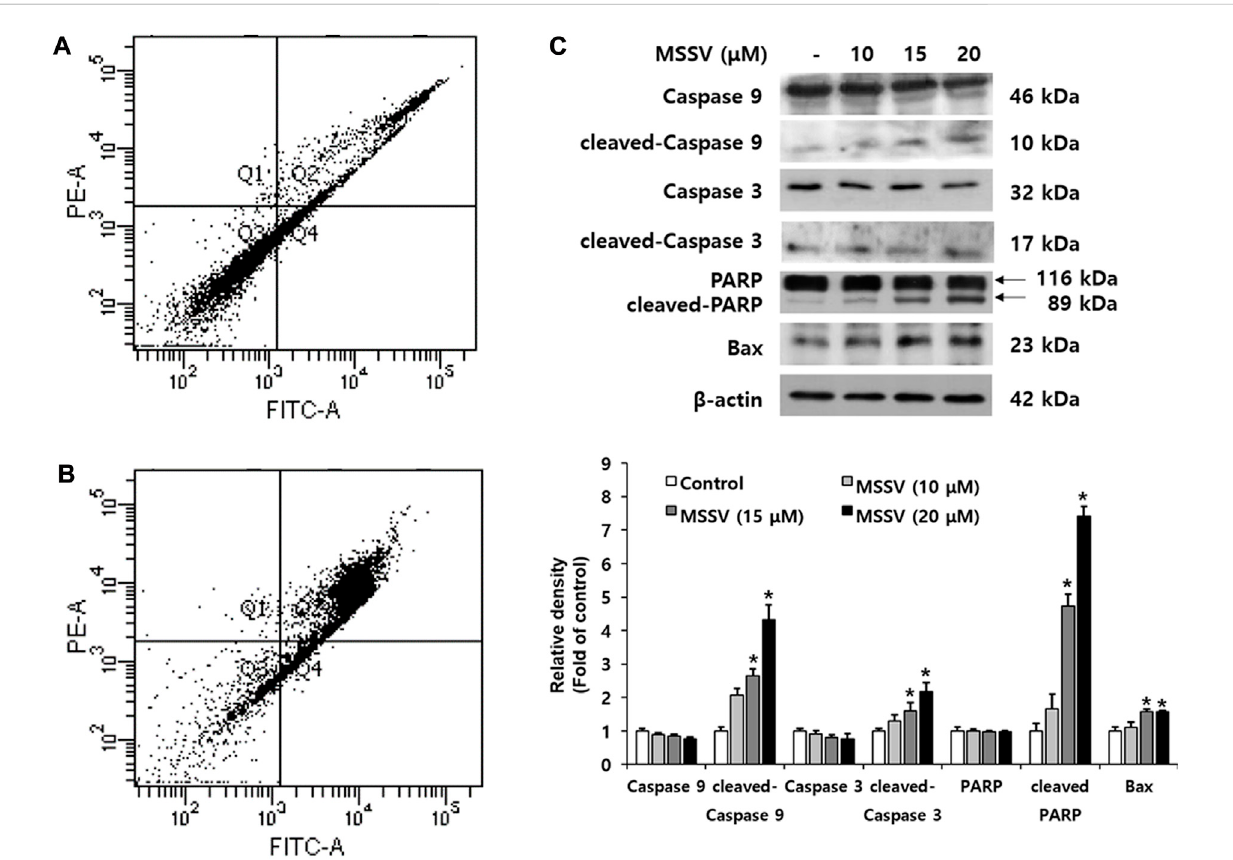
FIGURE 4 MSSV contributes a caspase-dependent intrinsic apoptotic pathway in HCT116 cells. (A) Control, and (B) HCT116 cells were treated with 20 μ M MSSV. HCT116 cells were stained by both Annexin V and PI staining. (C) MSSV-induced apoptosis factors in HCT116 cells were determined by immunoblotting. The cells were treated with MSSV at concentrations of 10, 15, and 20 μ M. The expression of pro-apoptotic proteins was increased by MSSVtreatment inHCT116 cells.Thebarrepresents therelativefoldchangesinproteins atdifferentconcentrationsofMSSVincomparisonwiththe control. Data are presented as mean ± SD and the * (asterisk) indicated statistically signi fi cant difference. A p -value of < 0.05 was considered statistically signi fi